Question: Write a descriptive caption for this figure.
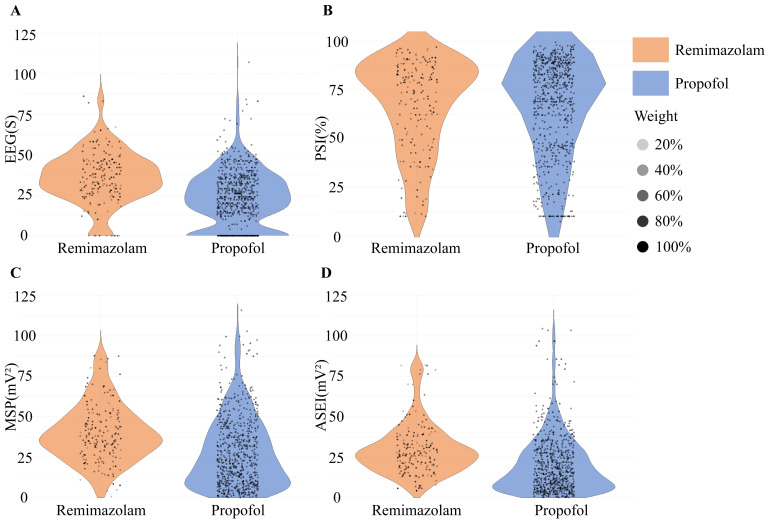
Answer: Comparison of ECT electroencephalographic monitoring parameters between the remimazolam and propofol groups. (A) Electroencephalographic sustained seizure duration; (B) Postictal suppression index; (C) Maximum sustained power; (D) Average seizure energy index. In the violin plots, each point represents one ECT session, with point shading reflecting sIPTW weight.